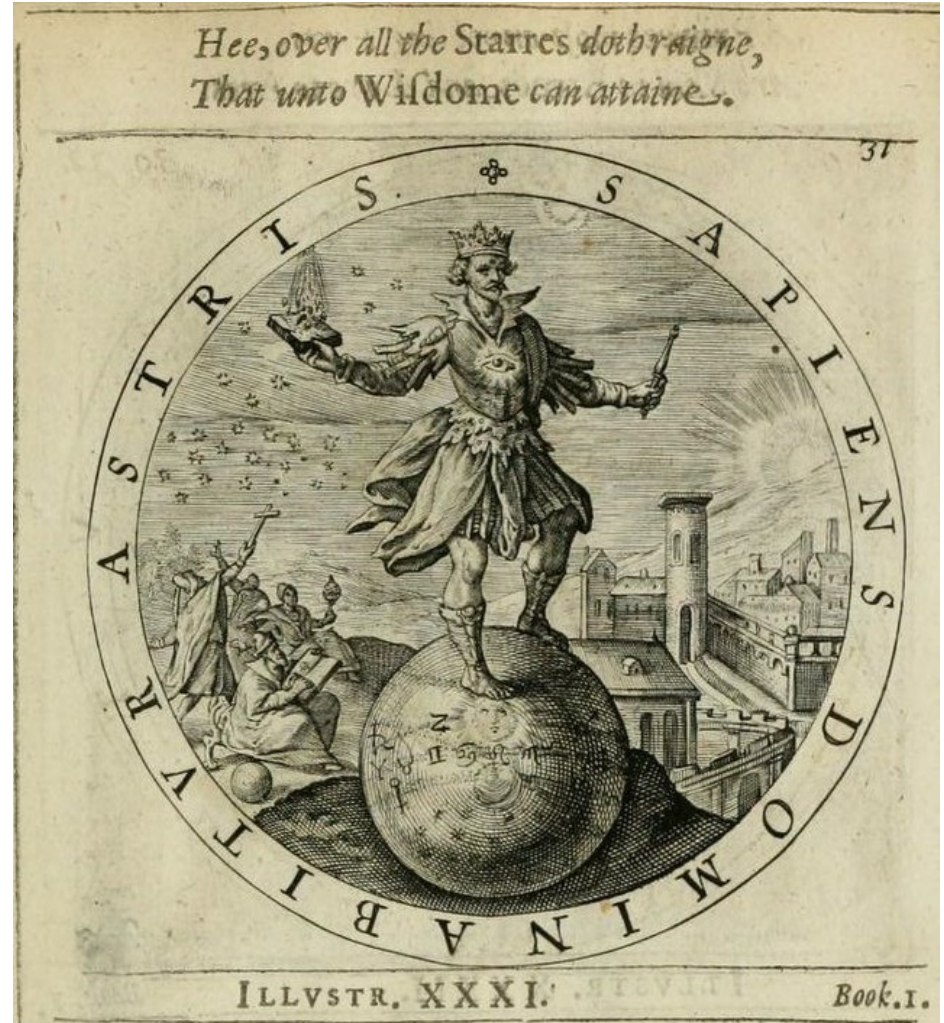
Figure 2. George Wither, A Collection of Emblemes Ancient and Moderne (London, 1635), Book I, Emblem 31. Public Domain.